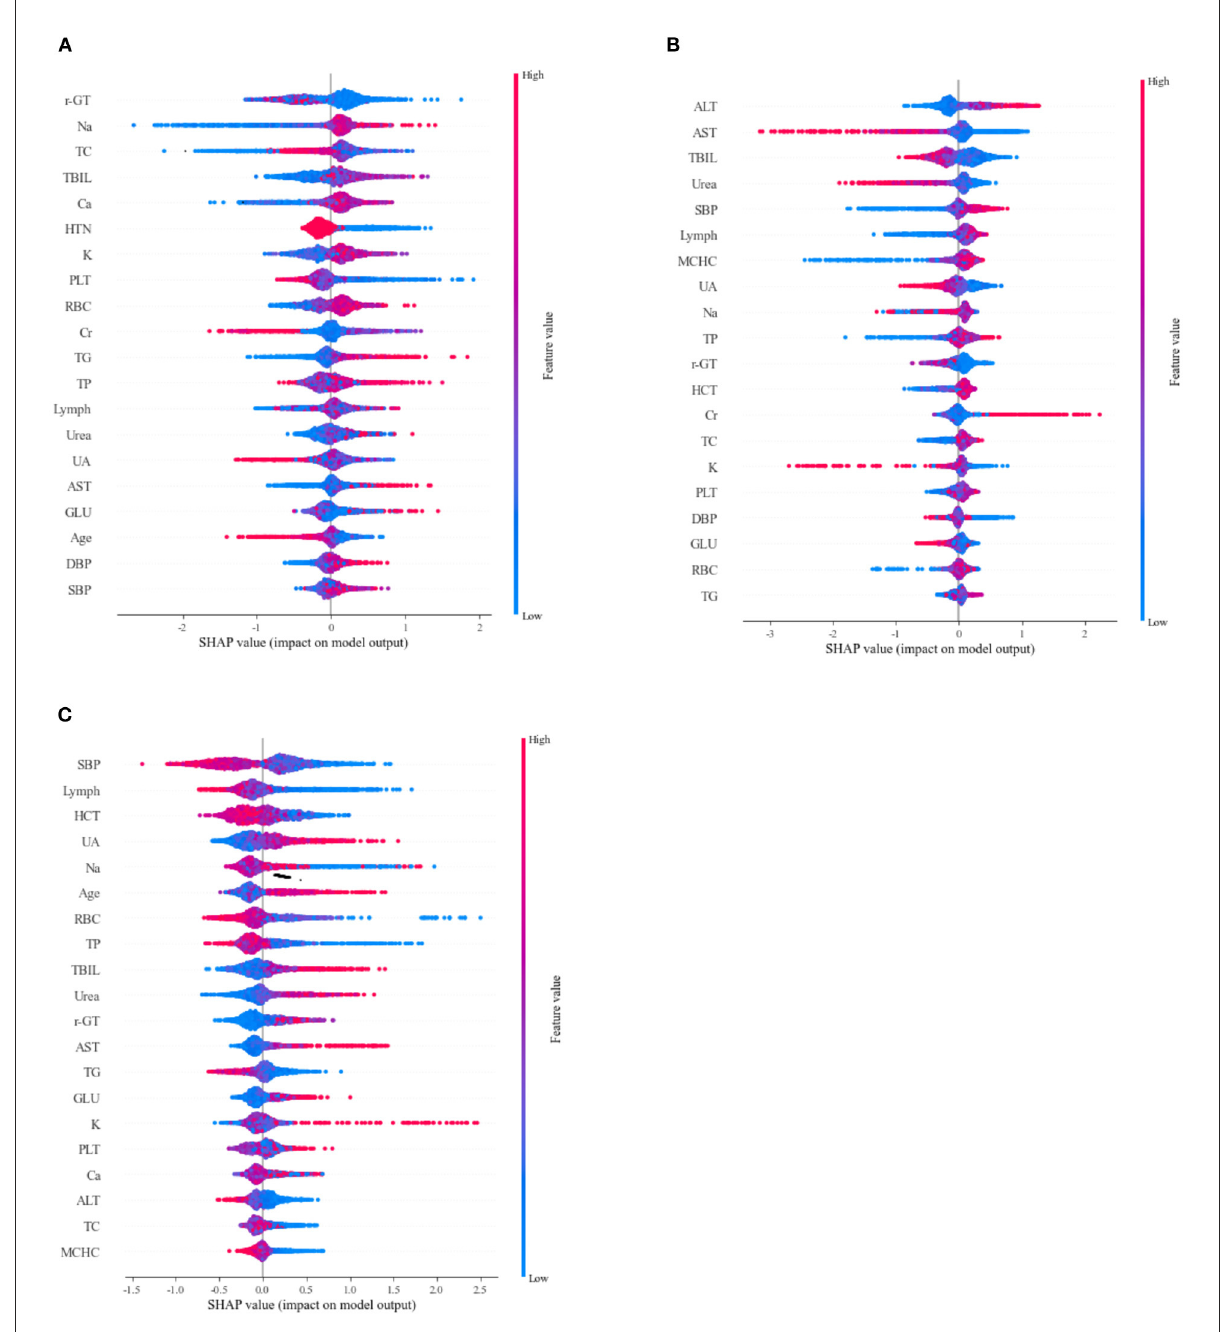
FIGURE6 Sapropterin additivity interpretation (SHAP) scores were used to determine important features for predicting different drugs (A) Perindopril, (B) Amlodipine, and (C) Furosemide. Colors indicate whether the value of the feature is high (red) or low